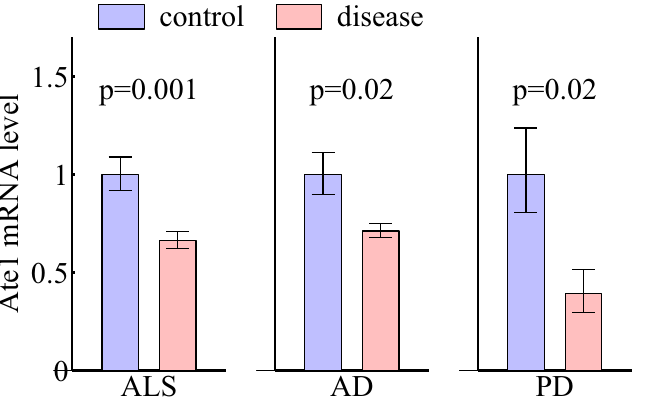
Figure 10. Levels of Ate1 mRNA are significantly lower in several types of neurodegenerative diseases. ALS: amyotrophic lateral sclerosis, comparing mouse microglia sorted from whole spinal cord of control and late stage TDP-43 proteinopathy, calculated from the public GSE109171 RNAseq data set 75 normalized to β -actin. AD: Alzheimer’s disease, comparing laser captured human hippocampal gray matter of normal brain and severe AD patients, calculated from the public GSE28146 microarray data set 76 using RMA method. PD: Parkinson’s disease, comparing laser-captured human dopaminergic neurons in substantia nigra of normal brain and PD patients, calculated from the public GSE20141 microarray data set 77 using RMA method. Plot showing relative Ate1 mRNA expression levels. Calculation was performed in log2 unit and plotted in linear fashion. The error bars represent SEM and the p-values are from Welch’s